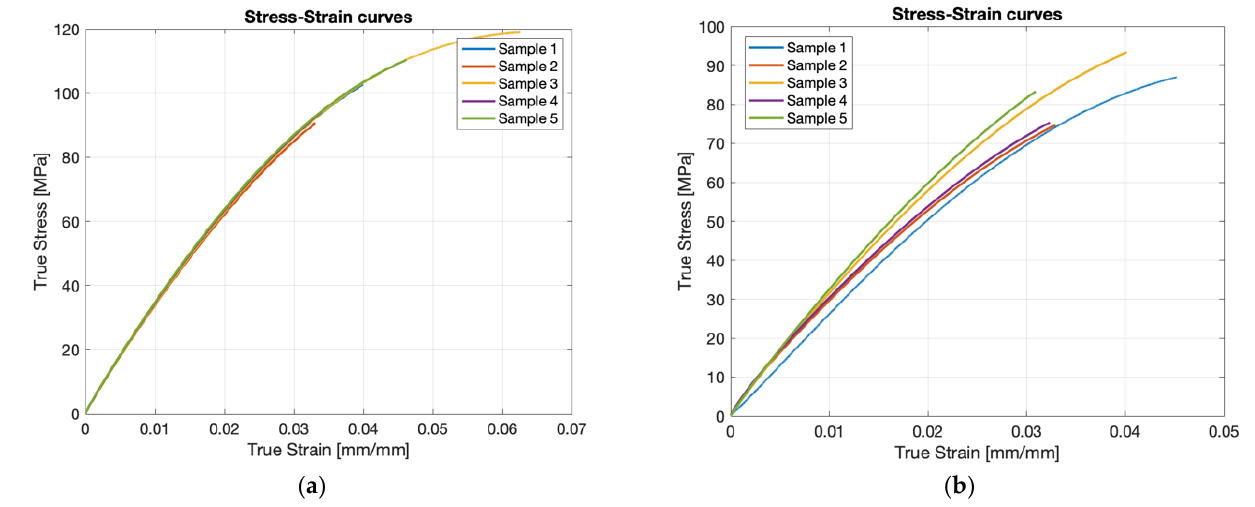
Figure 6. Tensile stress-strain curves for dried ( a ) and undried ( b ) materials.